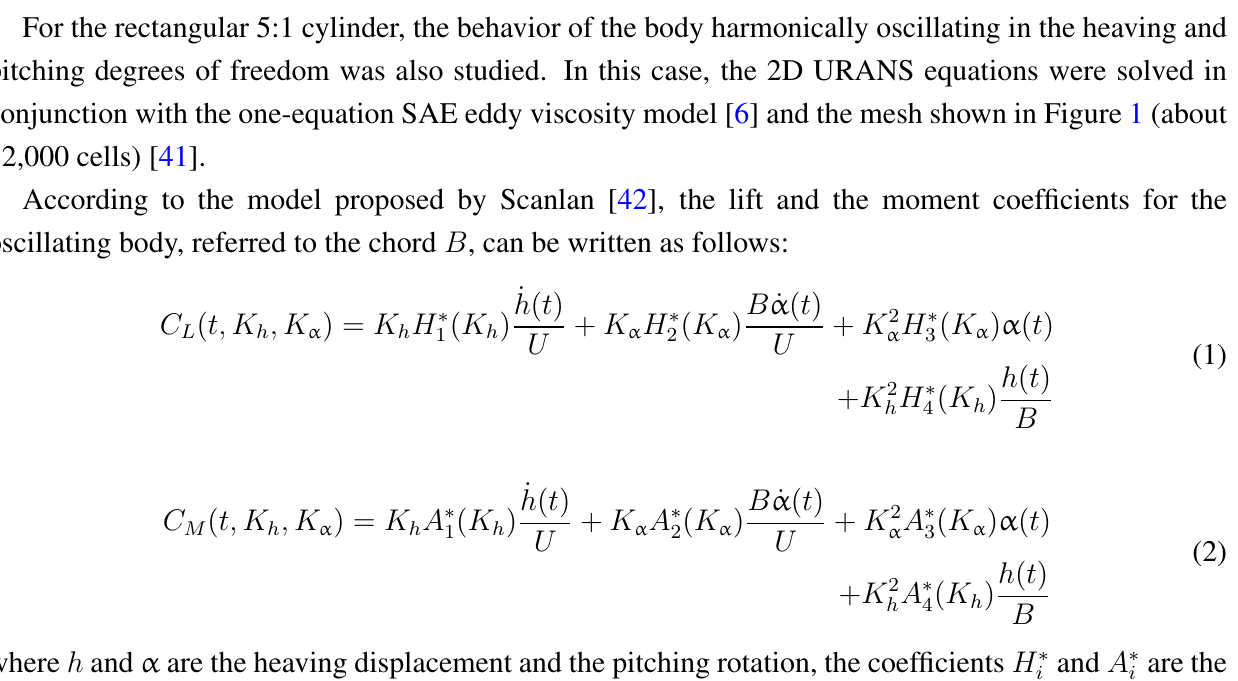
Figure 5. Snapshots of normalized turbulent kinetic energy ( k/U 2 cylinder with α = +4 ◦ at Reynolds numbers of 5200 ( a ) and 370,000 ( b